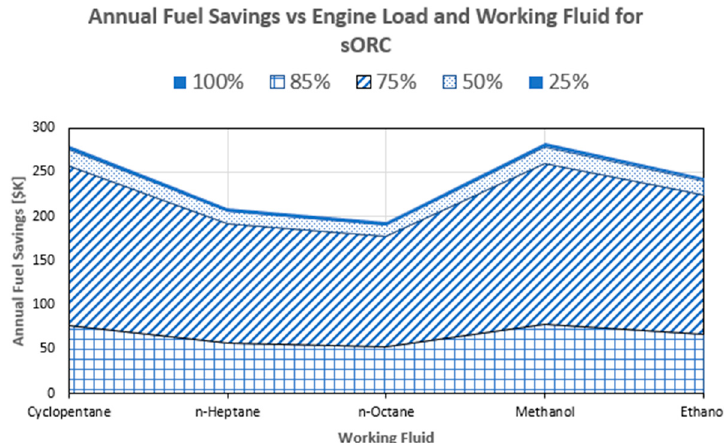
Figure 9. Annual fuel savings for different engine loads and working fluids.